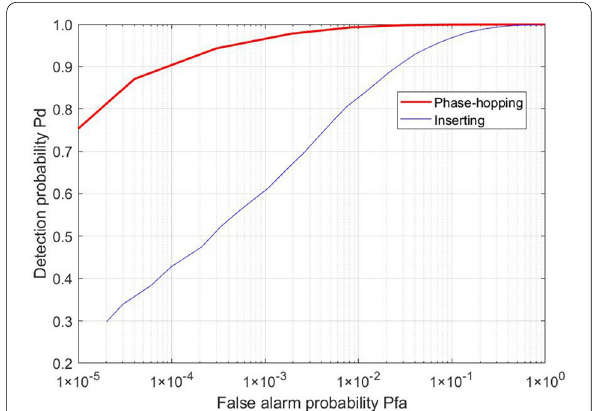
Fig. 8 ROC performance ( C (cid:31) N 0